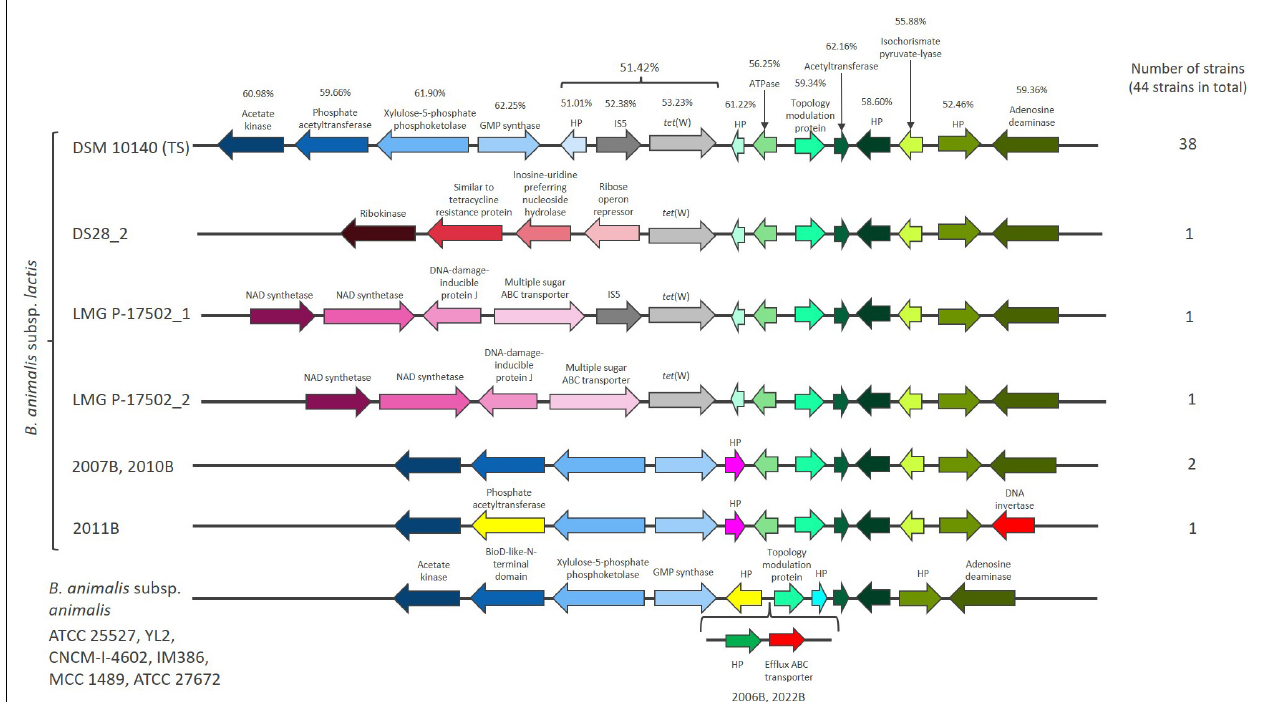
FIGURE 1 | The chromosomal region flanking tet (W) in Bifidobacterium animalis subsp. lactis and the same region in Bifidobacterium animalis subsp. animalis. Hypothetical proteins are designated HP. GC content (%) is provided for the genes found in the B. animalis subsp. lactis type strains (TS) DSM 10140. Genes that are present in the majority of the examined B. animalis subsp. lactis strains (represented by DSM 10140) has the same color in all the shown strains [blue colors downstream of tet (W) and green colors upstream of tet (W)].